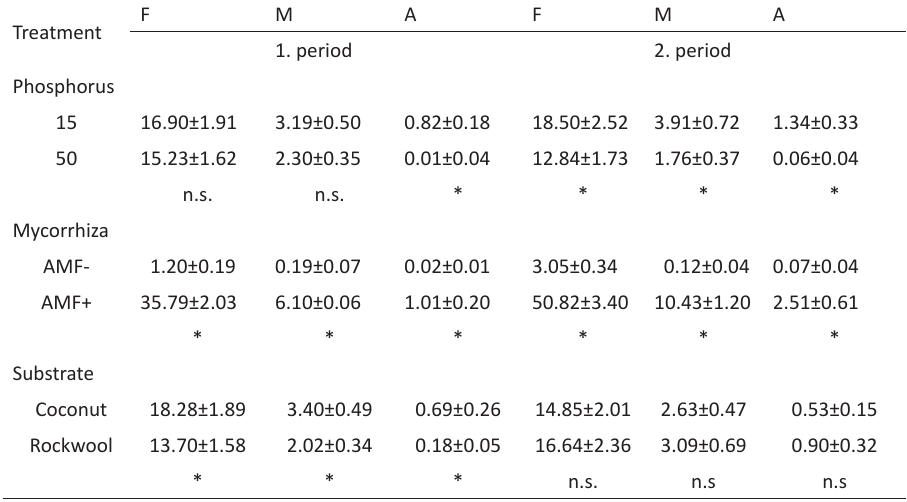
Table 1. Effect of phosphorus level in nutrient solution (mg dm -3 ), mycorrhiza and type of substrate